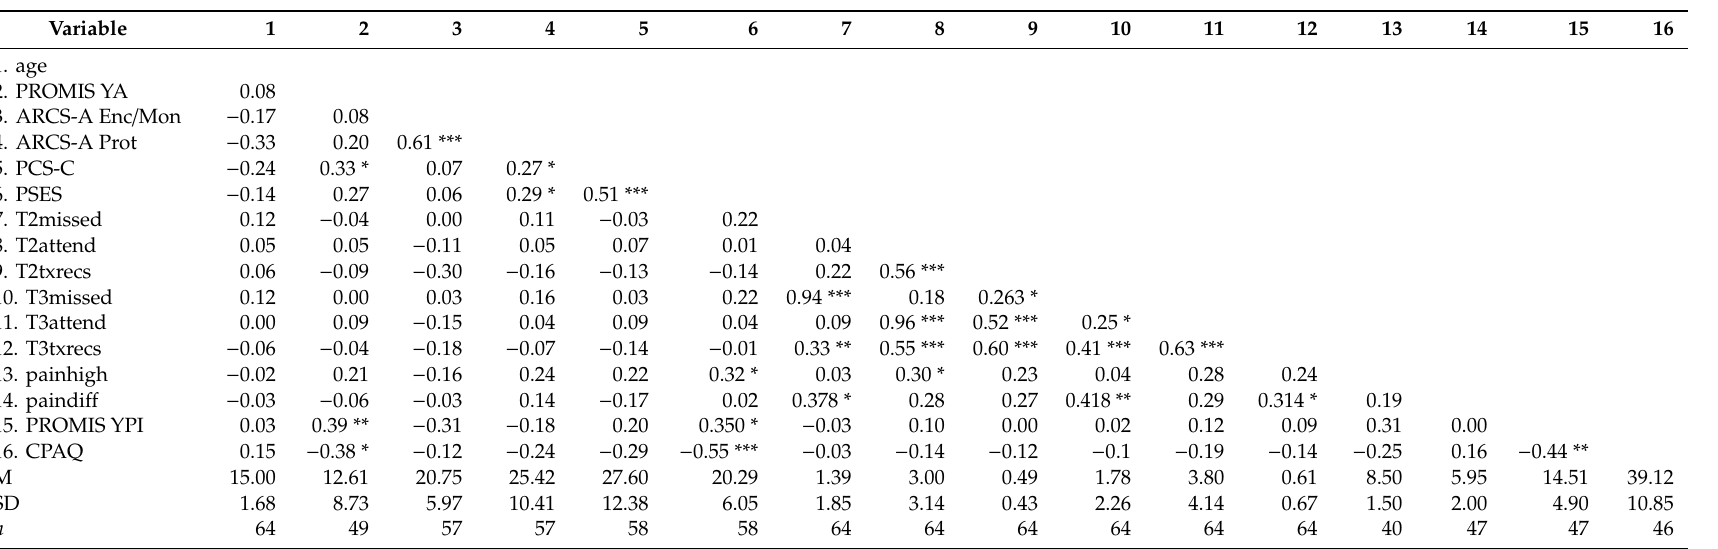
Table 1. Bivariate Correlations among Continuous Study